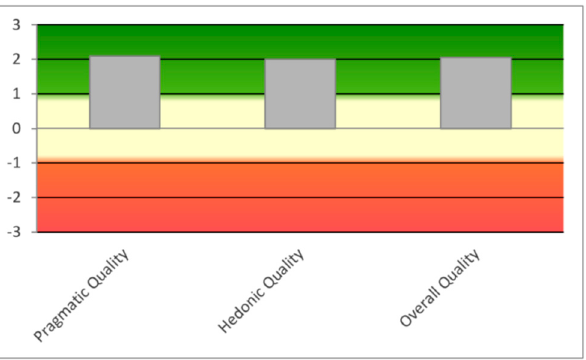
Figure 7. Evaluation of the shown content of the Crop Portal at the end of the crop cycle.